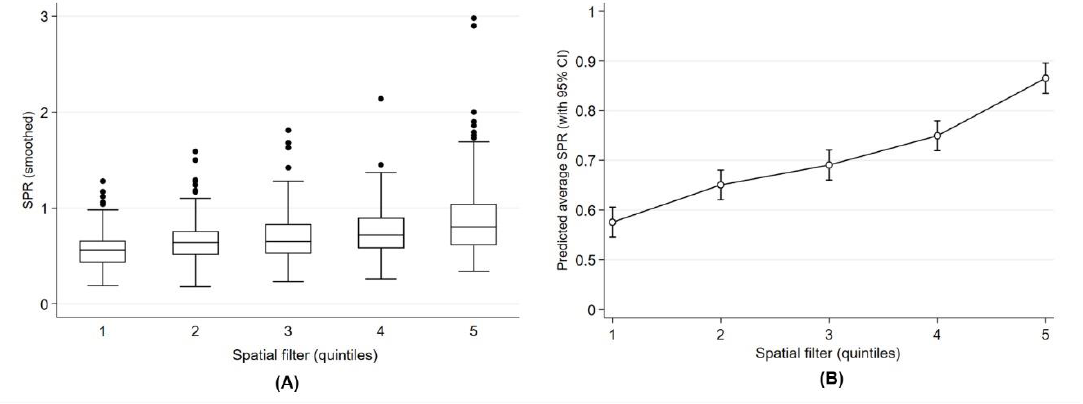
Figure 3. Geographic gradient of smoothed SPR ( A ) and predicted average of SPR ( B ) across Calgary zones defined by the spatial filter quintiles in Calgary.